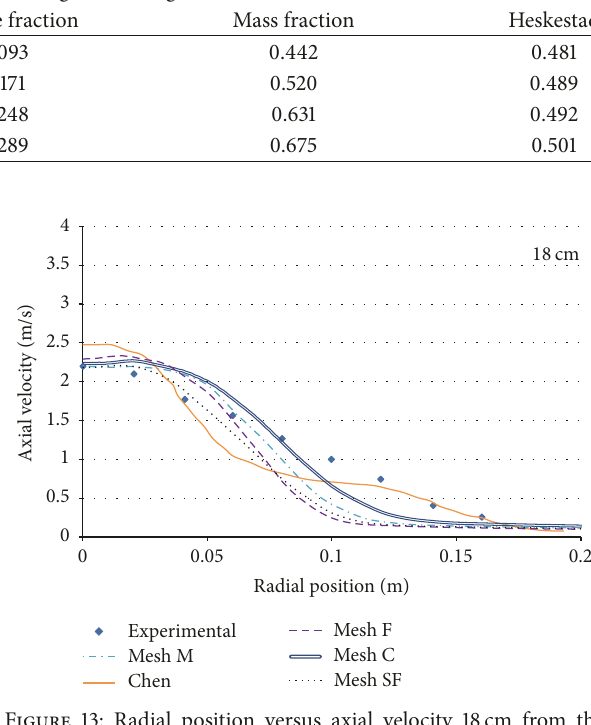
Figure 13: Radial position versus axial velocity 18 cm from the burner exit.